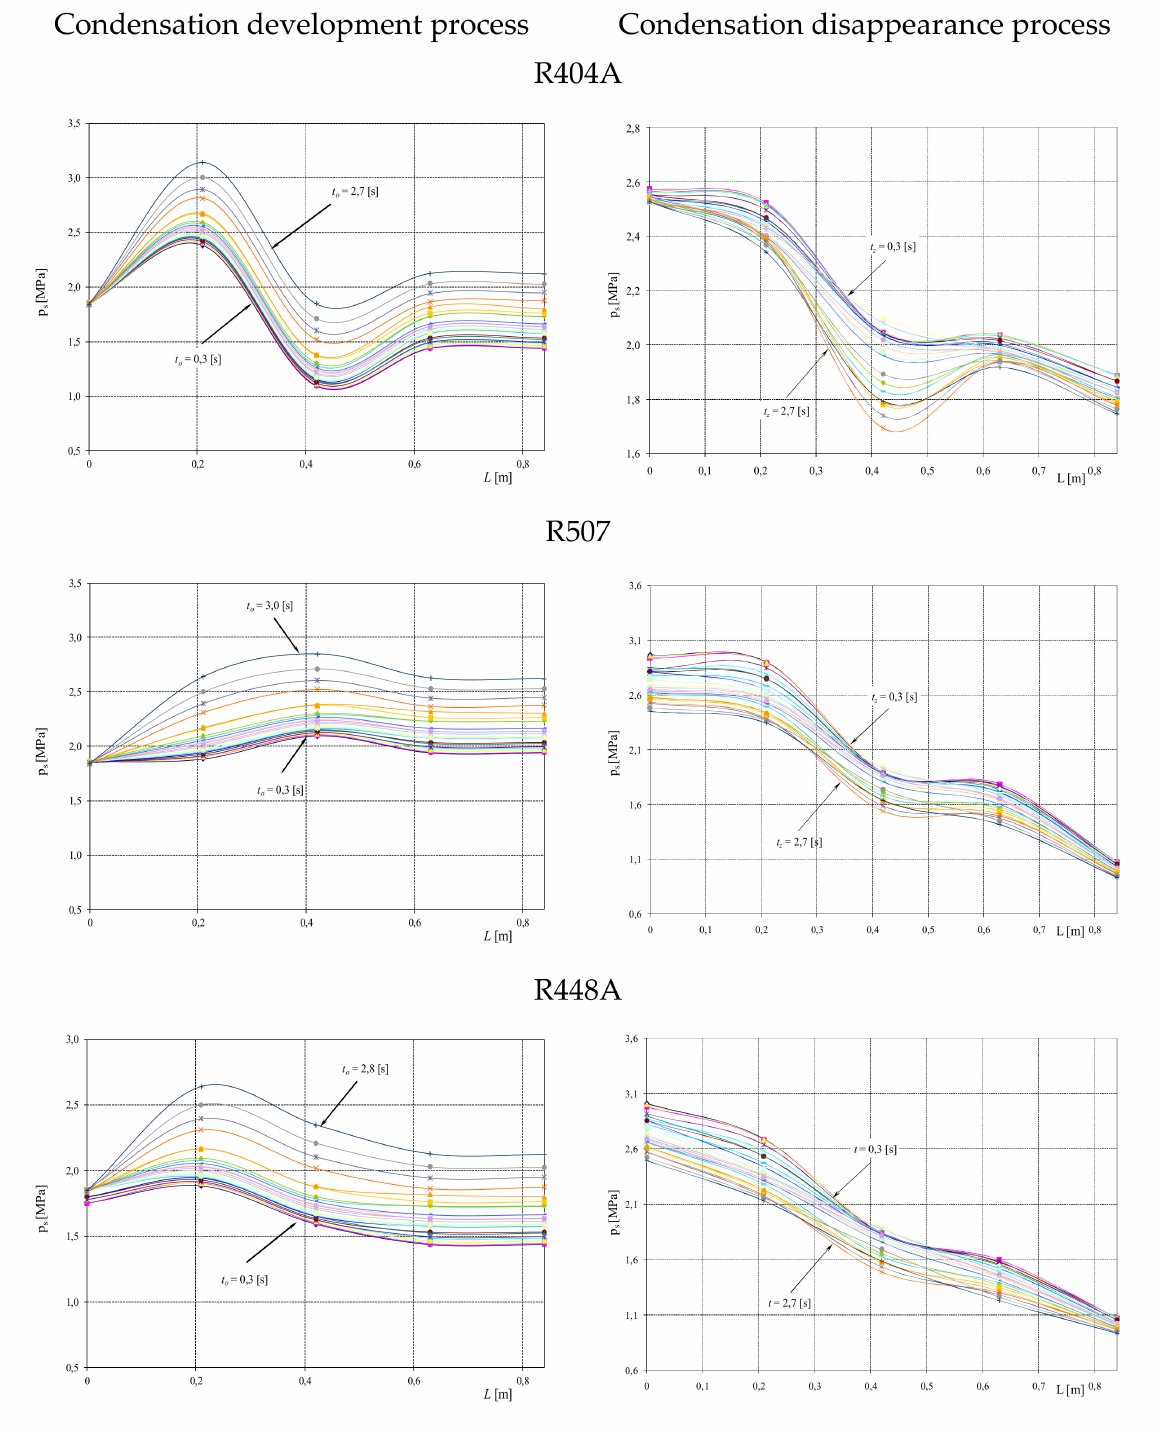
Figure 4. Distribution of the pressure, p s of the tested refrigerants depending on the cutoff valve opening and closing time, tc , for an inner diameter of the tested minichannel, d i = 3.30